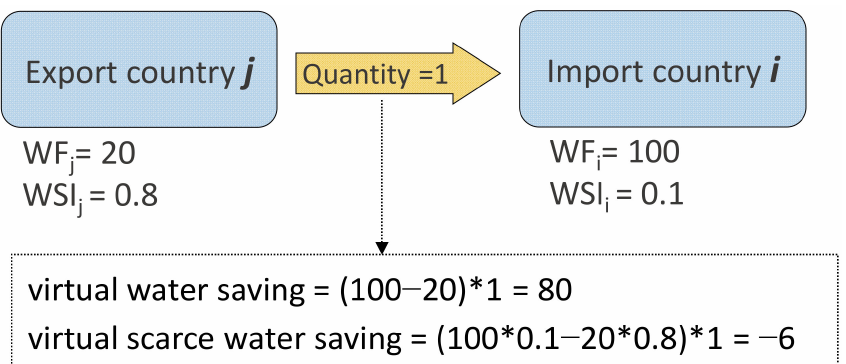
Figure 1. An example depicts how virtual water flow can save global water resources and virtual scarce water. WF refers to water footprint and WSI stands for water stress